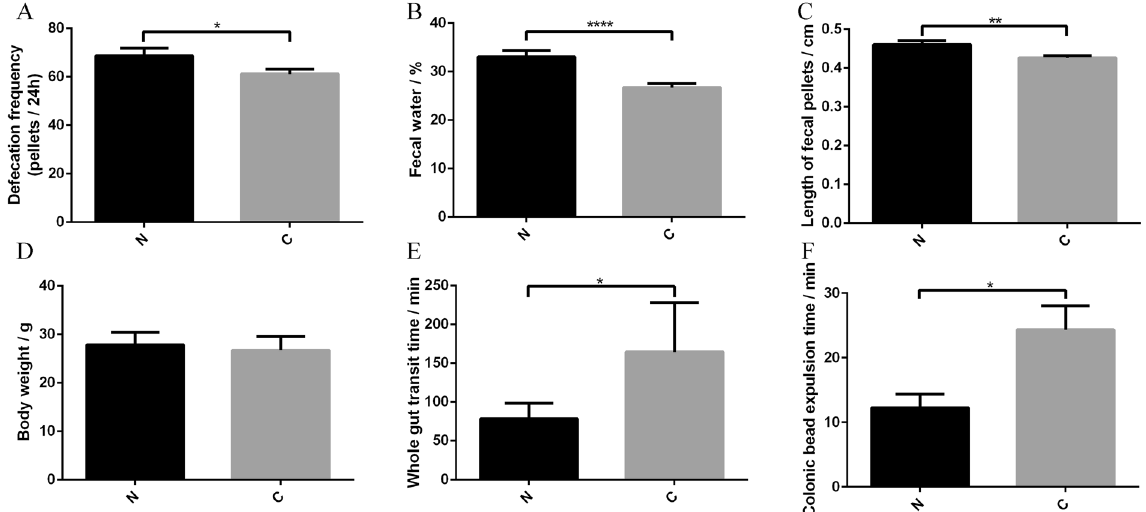
Figure 3. Transplantation of intestinal microbiota from STC donors has effects on defecation frequency (Group N = 20, Group S = 30) ( A ), fecal water content (Group N = 20, Group S = 30) ( B ), length of fecal pellets (Group N = 20, Group S = 30) ( C ), body weight after experiments (Group N = 20, Group S = 30) ( D ), total gastrointestinal transit time (Group N = 5, Group S = 10) ( E ), and colonic transit time (Group N = 5, Group S = 10) ( F ). Data represent the mean ± SEM. * p < 0.05, ** p < 0.01, *** p < 0.001, **** p < 0.0001. Group N: mice receiving fecal microbiota from healthy donor; Group C: mice receiving fecal microbiota from STC donors. STC: slow transit